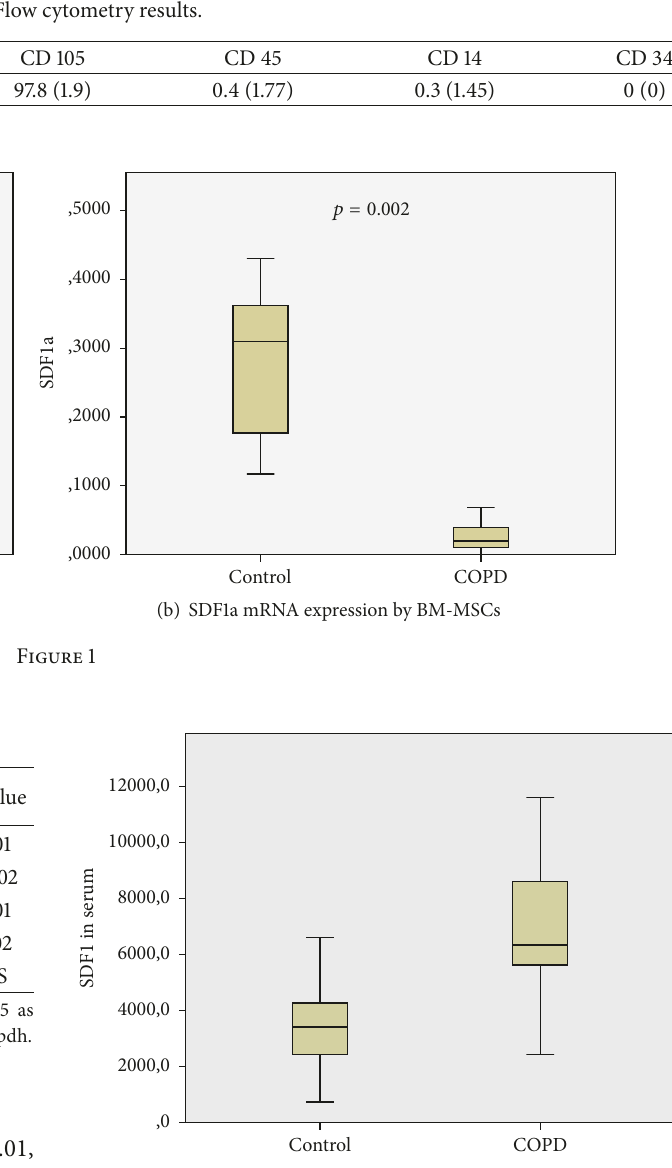
Figure 2: SDF1a protein levels in